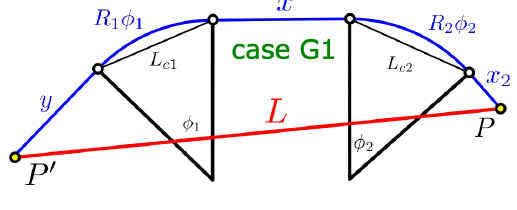
FIG. 5. Geometry for case G1.